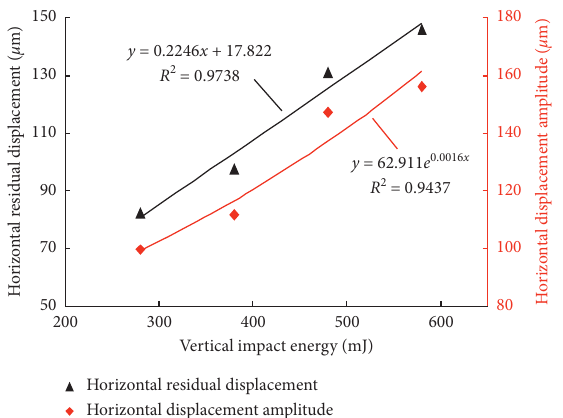
Figure 6: Relation curve between the vertical impact energy and the horizontal residual displacement and displacement amplitude of the working